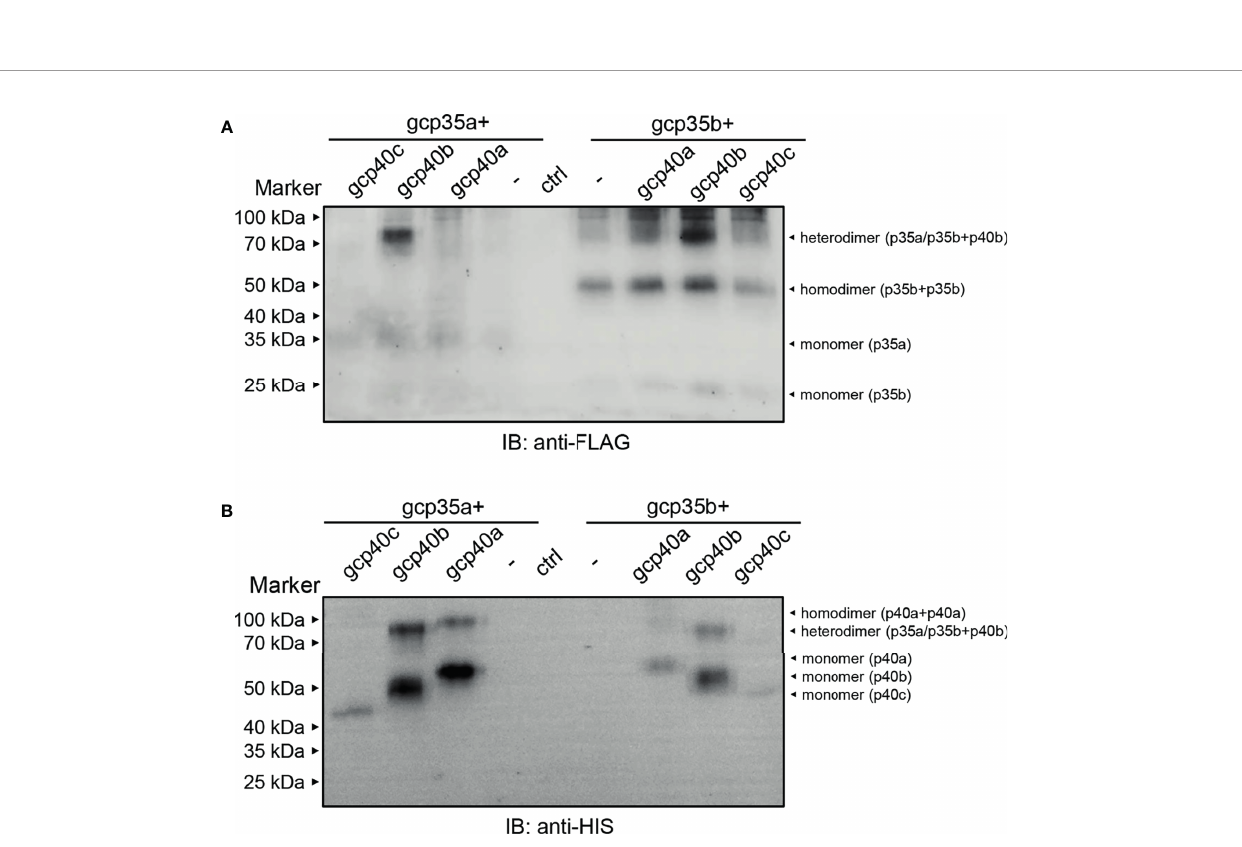
FIGURE 4 | Identi fi cation of the grass carp Il-12 heterodimer composition. HEK293 cells were transfected with 1.2 µg of plasmids encoding the individual subunits alone or with a mixture of 1.2 µg each of the two plasmids as indicated in picture. The cell culture media samples were separated under non-reducing conditions (without b -ME). The molecular mass standards (kDa) are indicated. The lane of ctrl means that HEK293 cells were transfected with a mixture of 1.2 µg each of the two vectors [p3×FLAG-CMV-7.1 and pcDNA 3.1/myc-His ( – )]. (A) Non-reducing WB assay by using anti-FLAG antibody. (B) Non-reducing WB assay by using anti- HIS